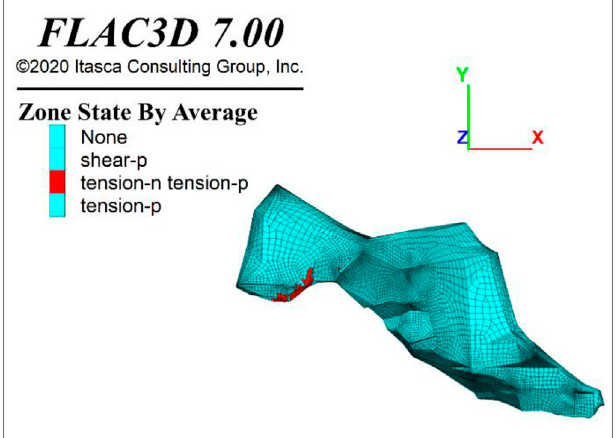
Frontiers in Physics |